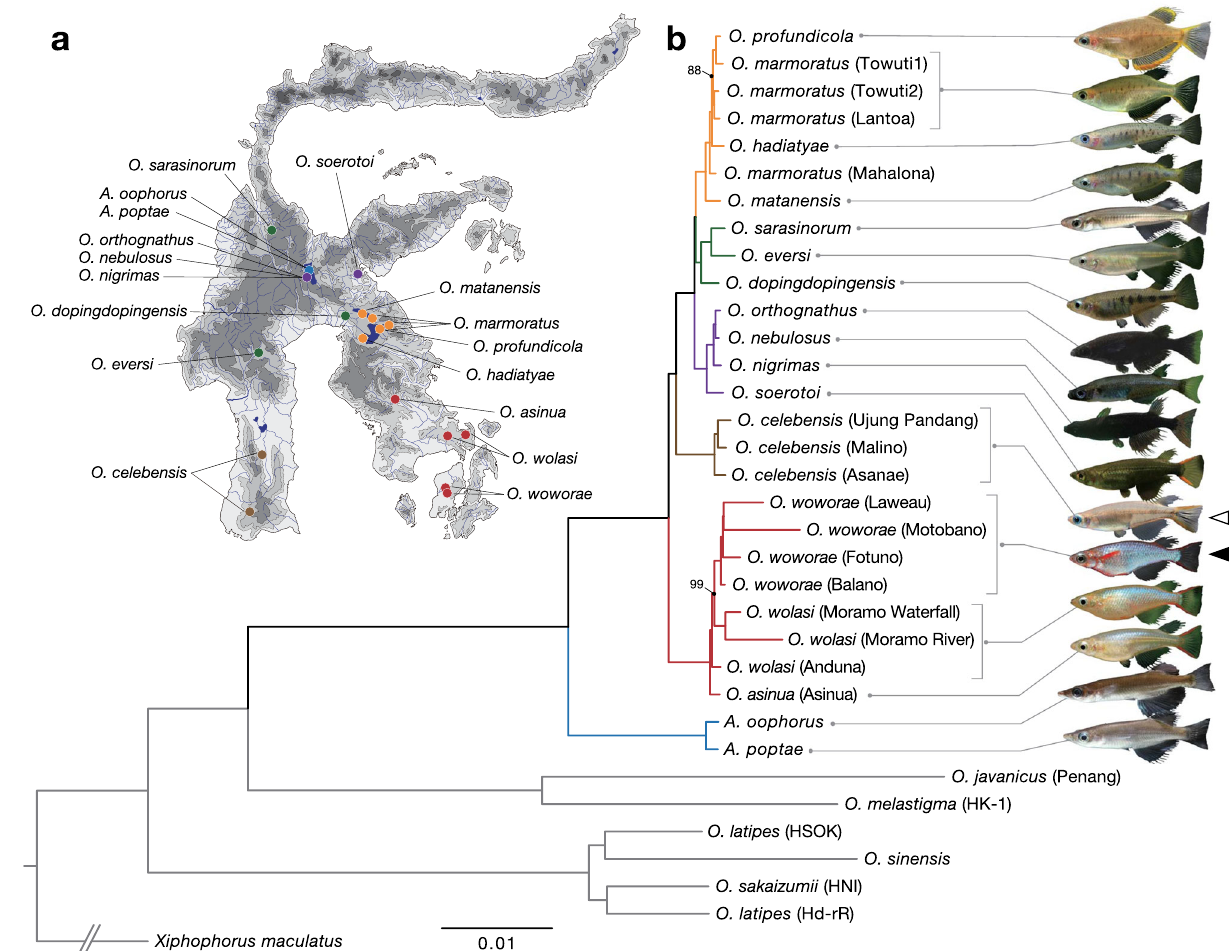
Fig. 1 Diversi fi cation of Adrianichthyidae in Sulawesi. a A map of Sulawesi showing sampling sites of 17 endemic species. The map was provided by Thomas von Rintelen. b A maximum-likelihood phylogenetic tree based on 10,174 single orthologous genes extracted from whole-genome sequencing data. The scale bar indicates the substitution rate. All branches except where noted were supported by 100% maximum-likelihood bootstrap values. Open and closed arrowheads indicate the reference and focal species in this study, respectively. The major lineages of Sulawesi species are shown in different